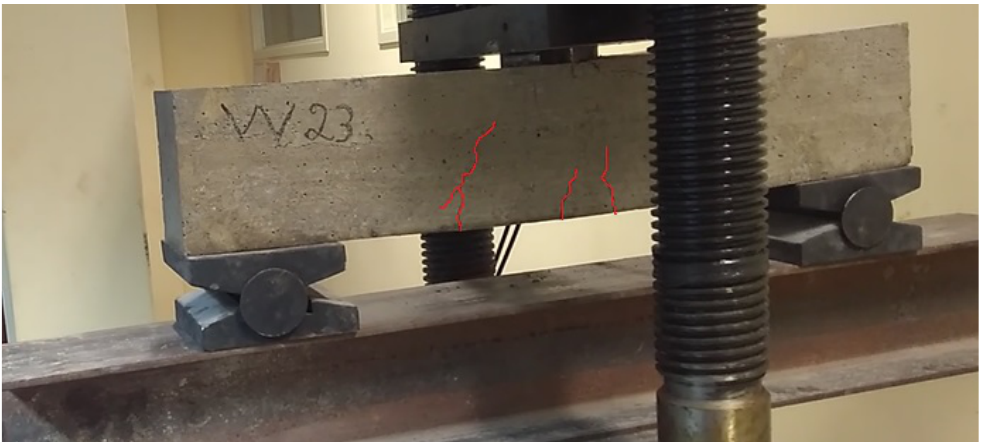
Figure 6. Cracks observed in the VV23